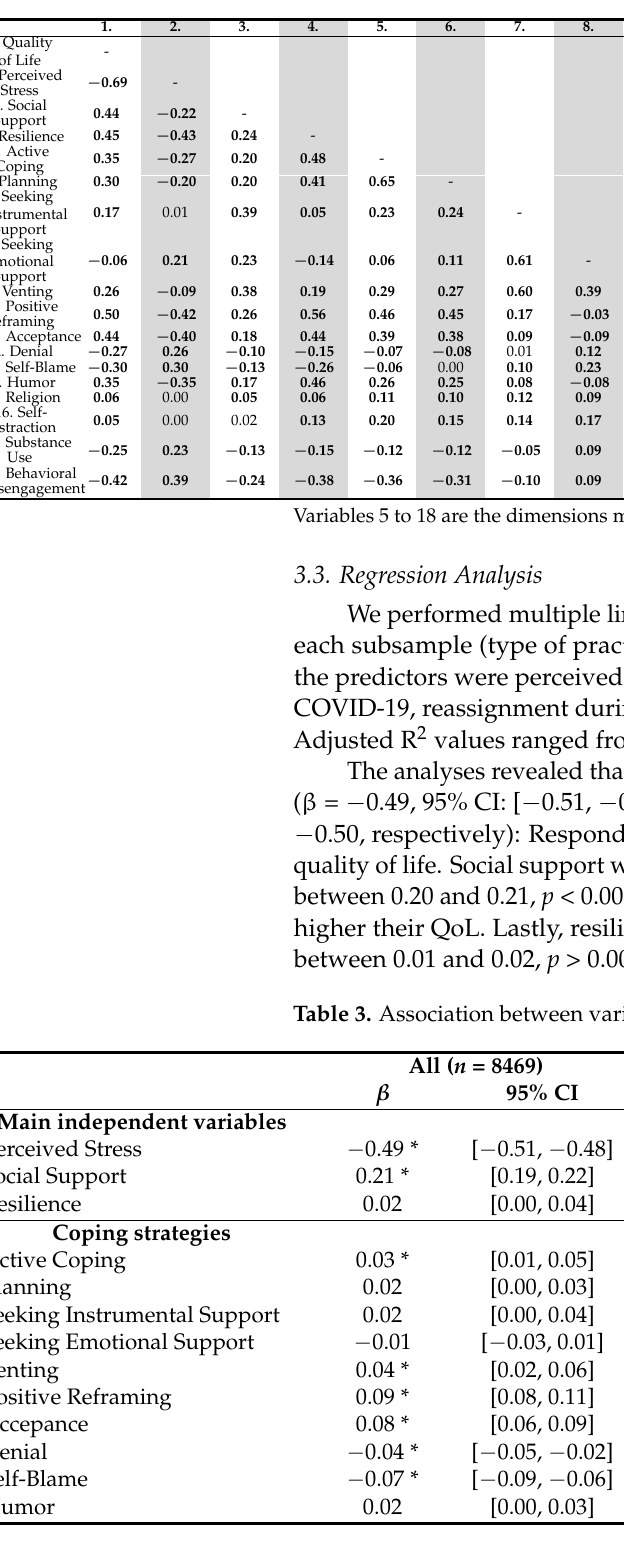
Table 2. Pearson’s correlations among all variables for the full sample.